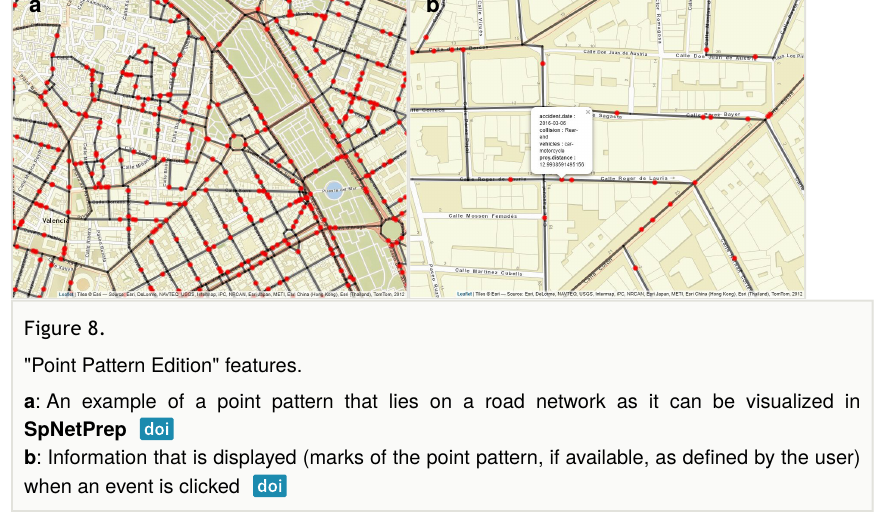
Figure 8. "Point Pattern Edition"